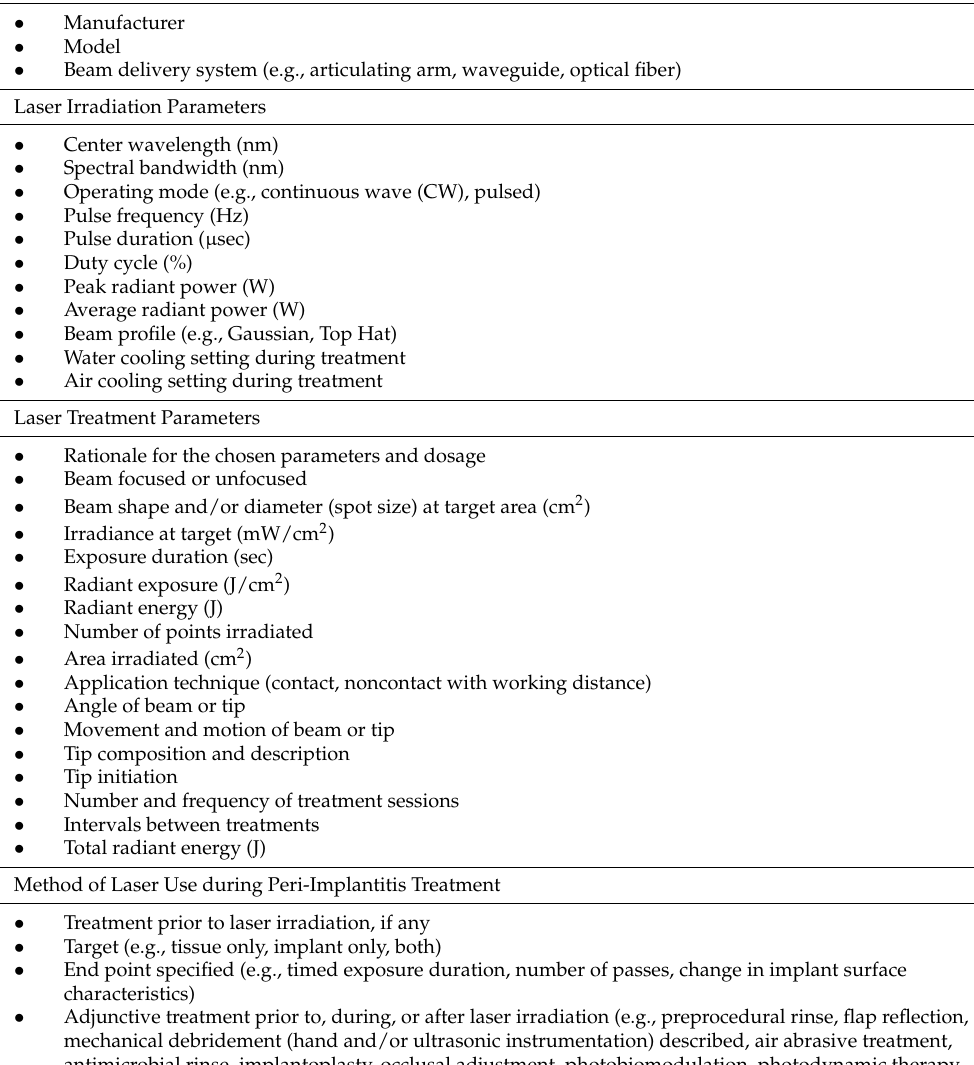
Table 9. Cont . Range of Variables That May Apply to Laser-Based Studies of Peri-Implantitis Treatment Laser Device